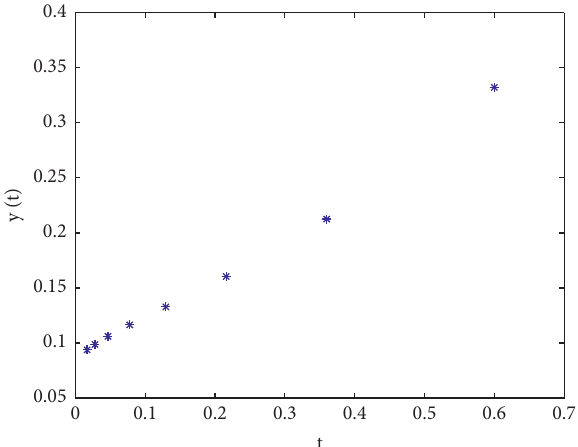
Figure 2: Behavior of the solution of system (62) in the ( t, y ) plane within T � 0 . 6s.